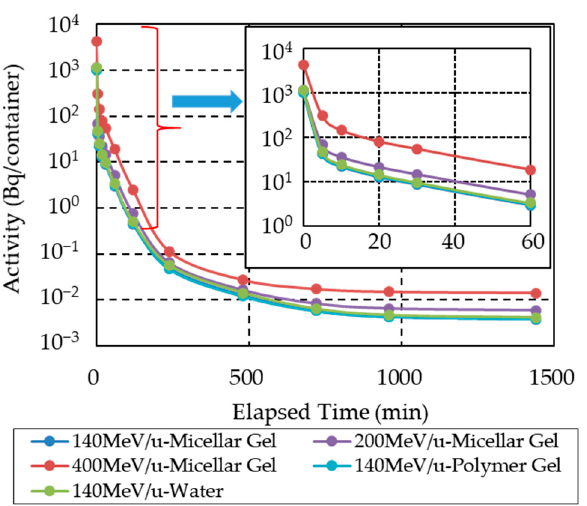
Figure 7. Simulated decay of total radioactivity under selected irradiation conditions. The simulations were carried out in the simple geometry configuration.